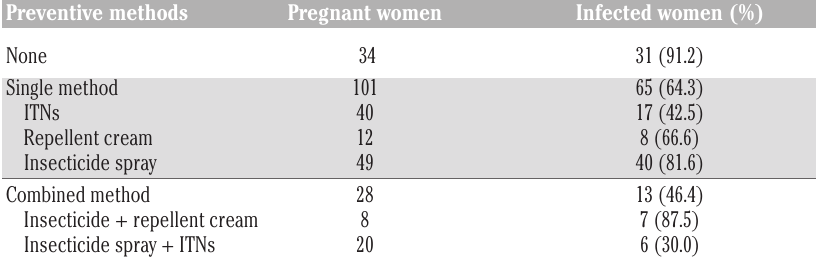
Table 2. Malarial infection in relation to preventive methods used among pregnant women attending the antenatal clinic at the Federal Medical Centre, Makurdi, Benue State,